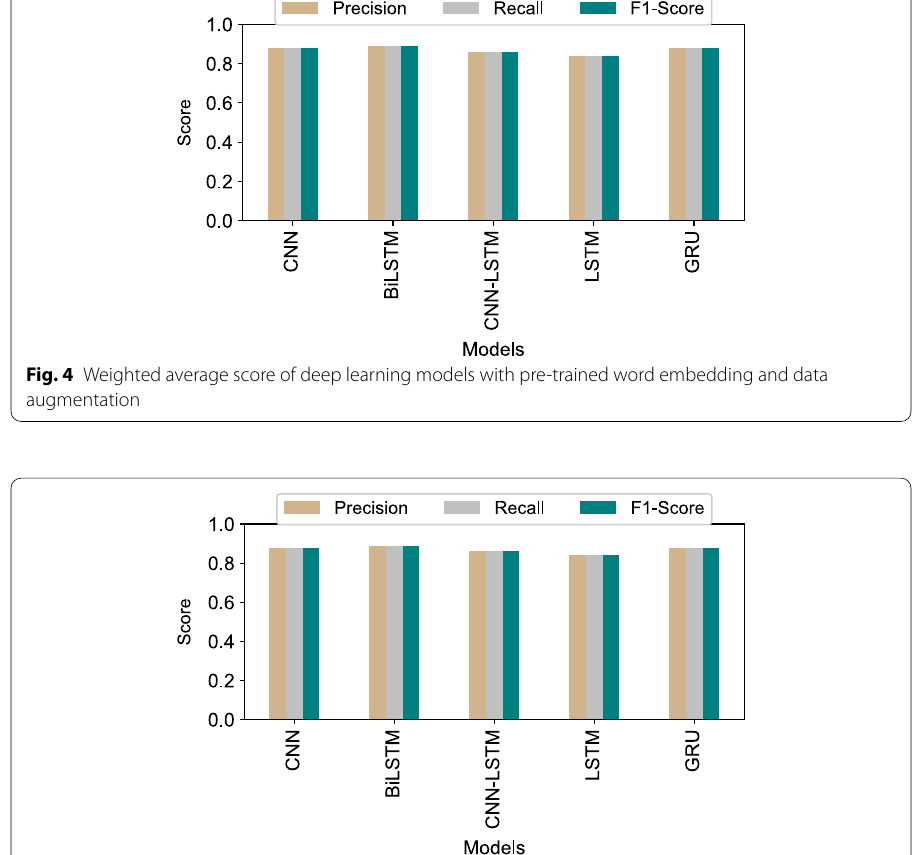
Fig. 5 Weighted average score of deep learning models trained with embedded representation and data